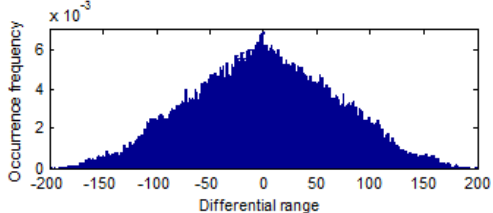
Figure 5. The disorder difference value distribution of the